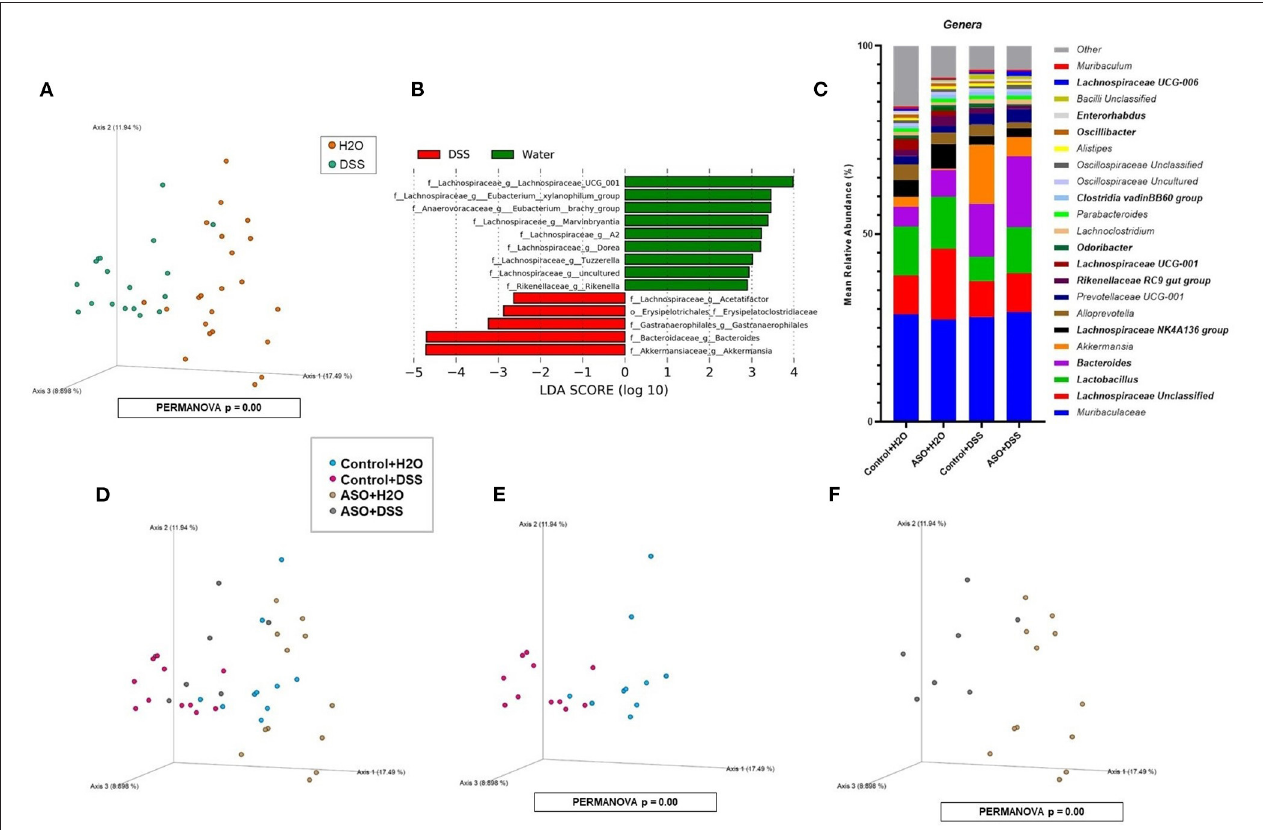
FIGURE 4 | Characterization of fecal microbiota in mice treatment and genotype groups using 16S rRNA sequencing. (A) Mice samples clustered separately between treatments, regardless of genotype. (B) LEfSe identified bacterial genera clades that are differentially abundant with treatment, irrespective of genotype. Clade colors: H 2 O (green) and DSS (red). Clades in this graph were statistically significant ( p < 0.05) and exceed an LDA log score of at least ( ± 2). (C) Bar charts of the mean relative abundance of fecal microbial communities at the taxonomic level of genus for mice genotypes with treatments. The mean relative abundance of taxa with > 1% average relative abundance are shown. (D–F) Fecal microbial communities clustered separately between mice genotypes with treatments. PCoA plots were built on Bray-Curtis dissimilarity metrics. H 2 O, water; DSS, dextran sodium sulfate; ASO, α -synuclein